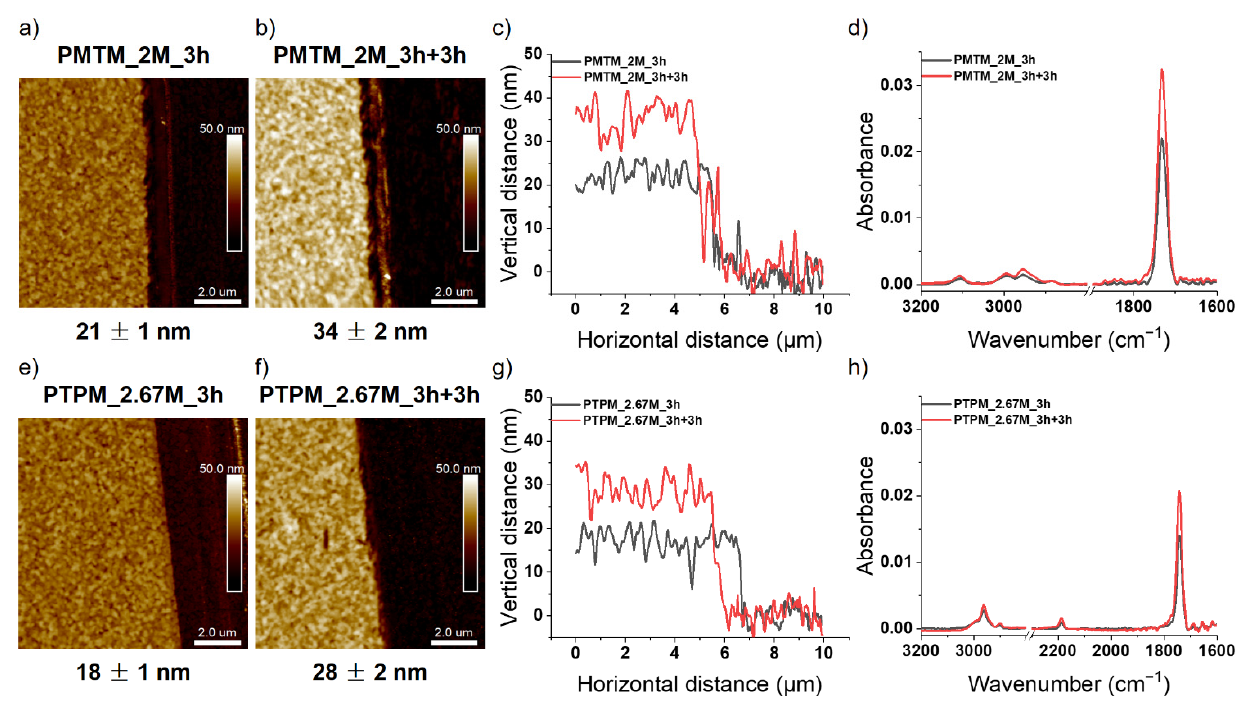
Figure 7. AFM images with representative cross-section profiles and FTIR spectra captured before and after chain extension of PMTM ( a – d ) and PTPM brushes ( e – h ).